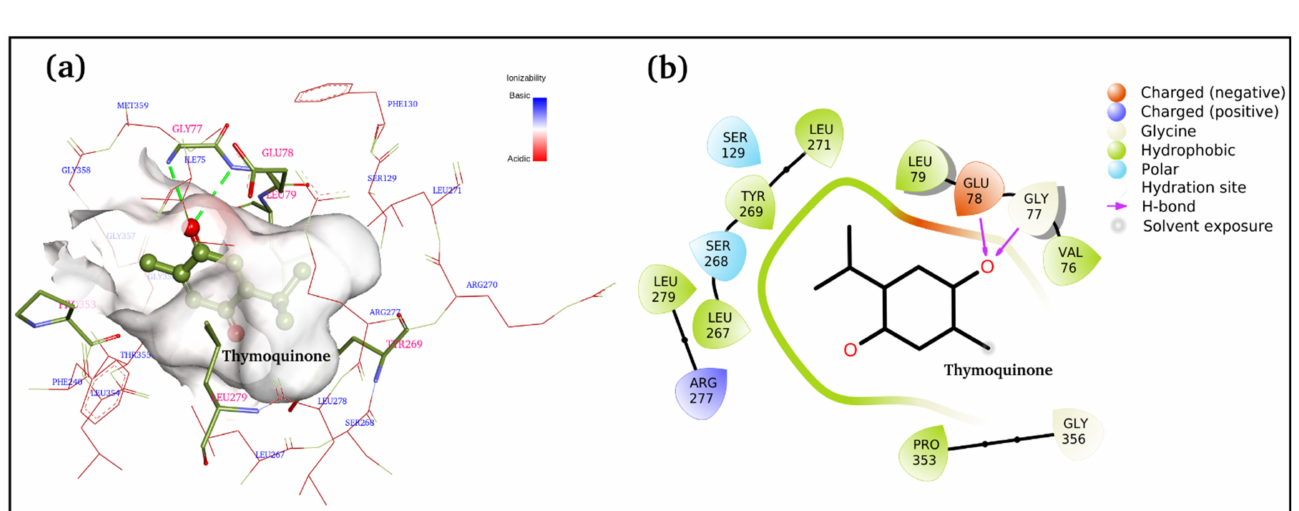
Figure 5. Docked complex of TQ and squalene monooxygenase with details of the binding interac- tions displayed. ( a ) 3D plot and ( b) 2D